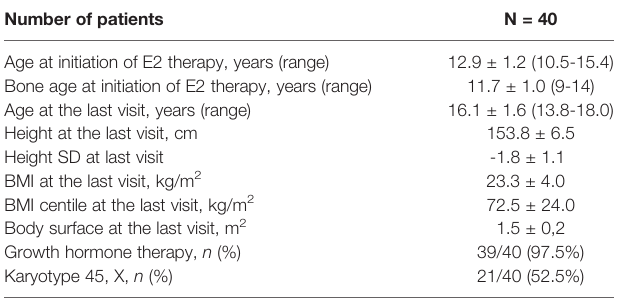
TABLE 1 | Clinical characteristics of the study group. Number of patients N =